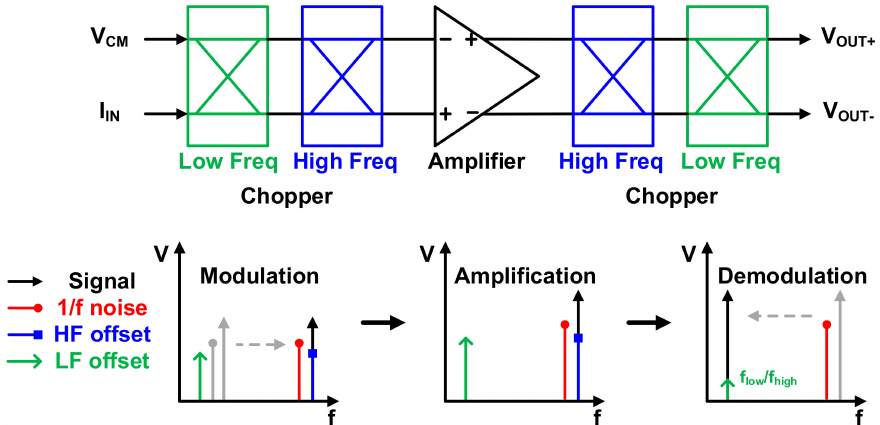
Figure 14. Nested chopper structure and operation.